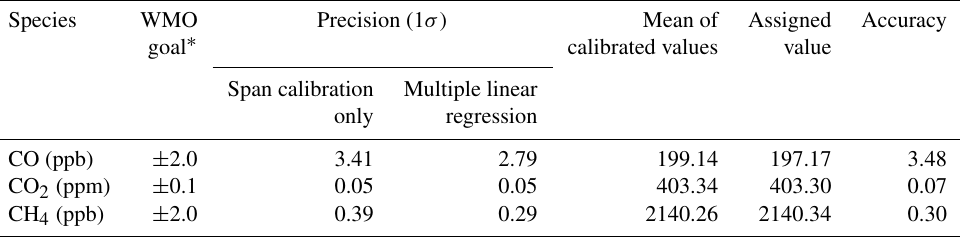
Table 2. Analytical precision and accuracy of the measurement system at the Beromünster tower estimated from daily target gas measure- ments over 19 months. The accuracy is determined using Eq. (2), with the precision obtained using the multiple linear regression approach.